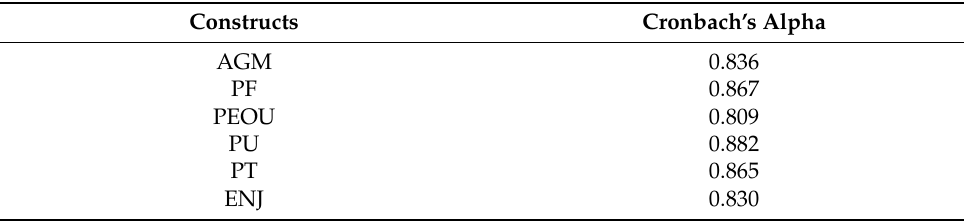
Table 4. Cronbach’s alpha values for the pilot study (Cronbach’s alpha ≥